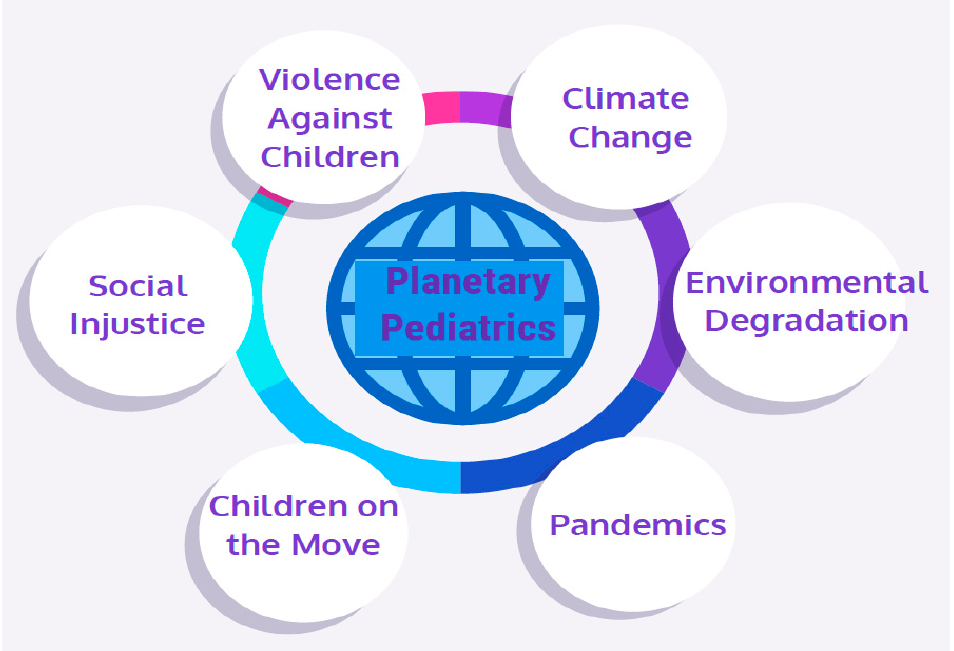
Figure 1. Planetary Pediatric Framework.